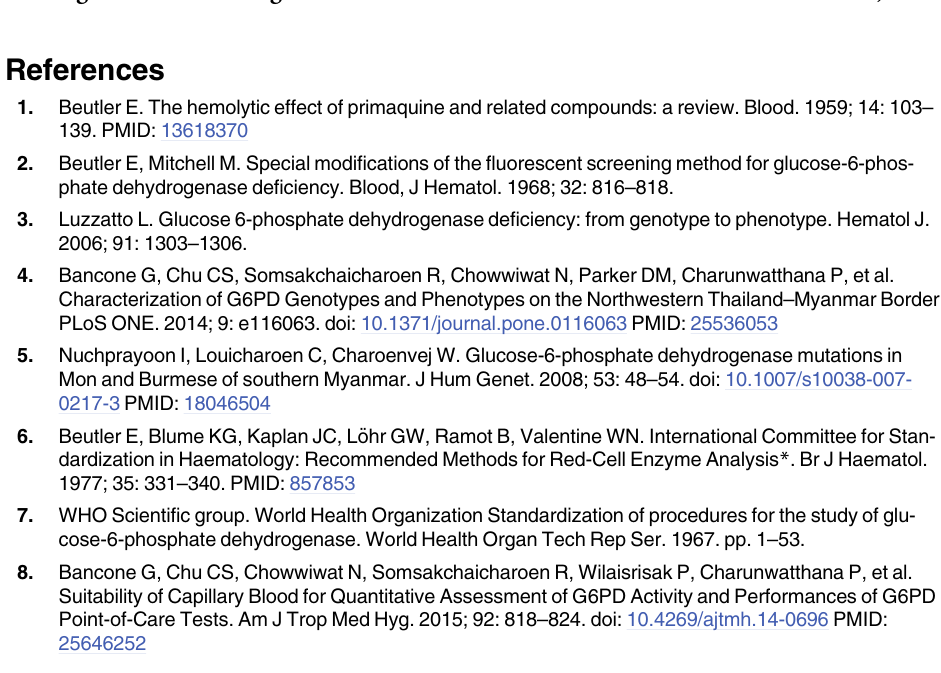
S2 Table. Daily mean fractional haematocrit changes by G6PD genotype and pooled by primaquine